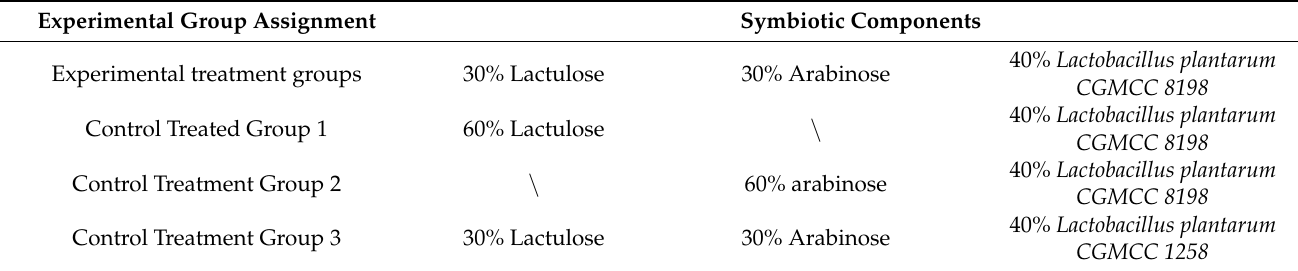
Table 1. The proportion of synbiotic components in each experimental